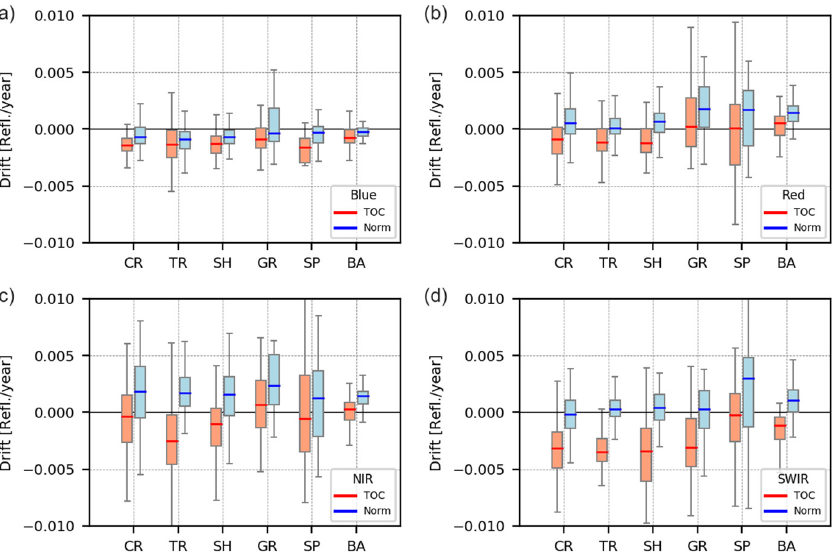
Figure 14. The figure shows the boxplots of estimated drifts in the four spectral bands for near-nadir observations (VZA < 10 ◦ ) aggregated per land cover class: Crop (CR), Tree (TR), Shrubland (SH), Grassland (GR), Sparse vegetation (SP), Bare soils (BA). Estimated drifts for TOC (red) and BRDF- normalized (blue) reflectances are presented for the bands: ( a ) Blue, ( b ) Red, ( c ) NIR, ( d ) SWIR. The parameters of the boxplot chart are those used and described in Figure 12.